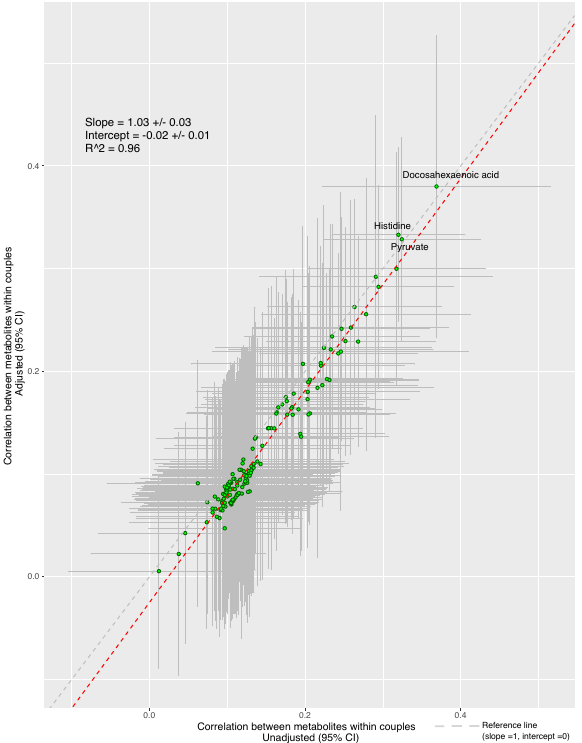
Figure 3. Scatterplot of adjusted versus unadjusted within couple correlation estimates across all metabolites. In adjusted analyses in males and females separately, metabolites (in SD units) were regressed on covariates (age, educational attainment, ever smoking, physical activity, family history of cardiometabolic disease, alcohol consumption, BMI, and ethnicity) and the residuals of those models use to estimate the adjusted Pearson correlation coefficients within couples. Unadjusted analyses were the Pearson correlation coefficients of the metabolites in SD units. The green dots highlight the individual metabolites. The grey dashed line reflects the reference line (slope 1, intercept 0) and the red dashed line is the best line of